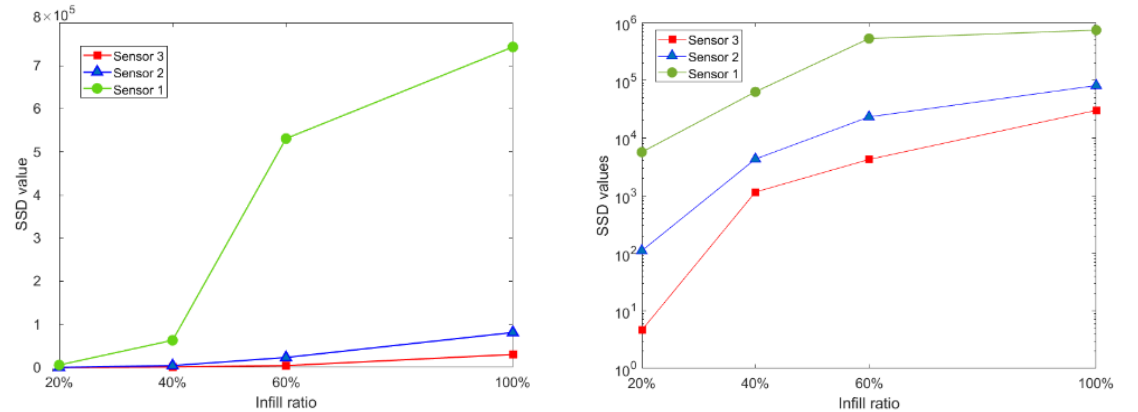
Figure 8. SSD values for the baseline and loaded condition in normal ( left ) and semi-log scale ( right ).